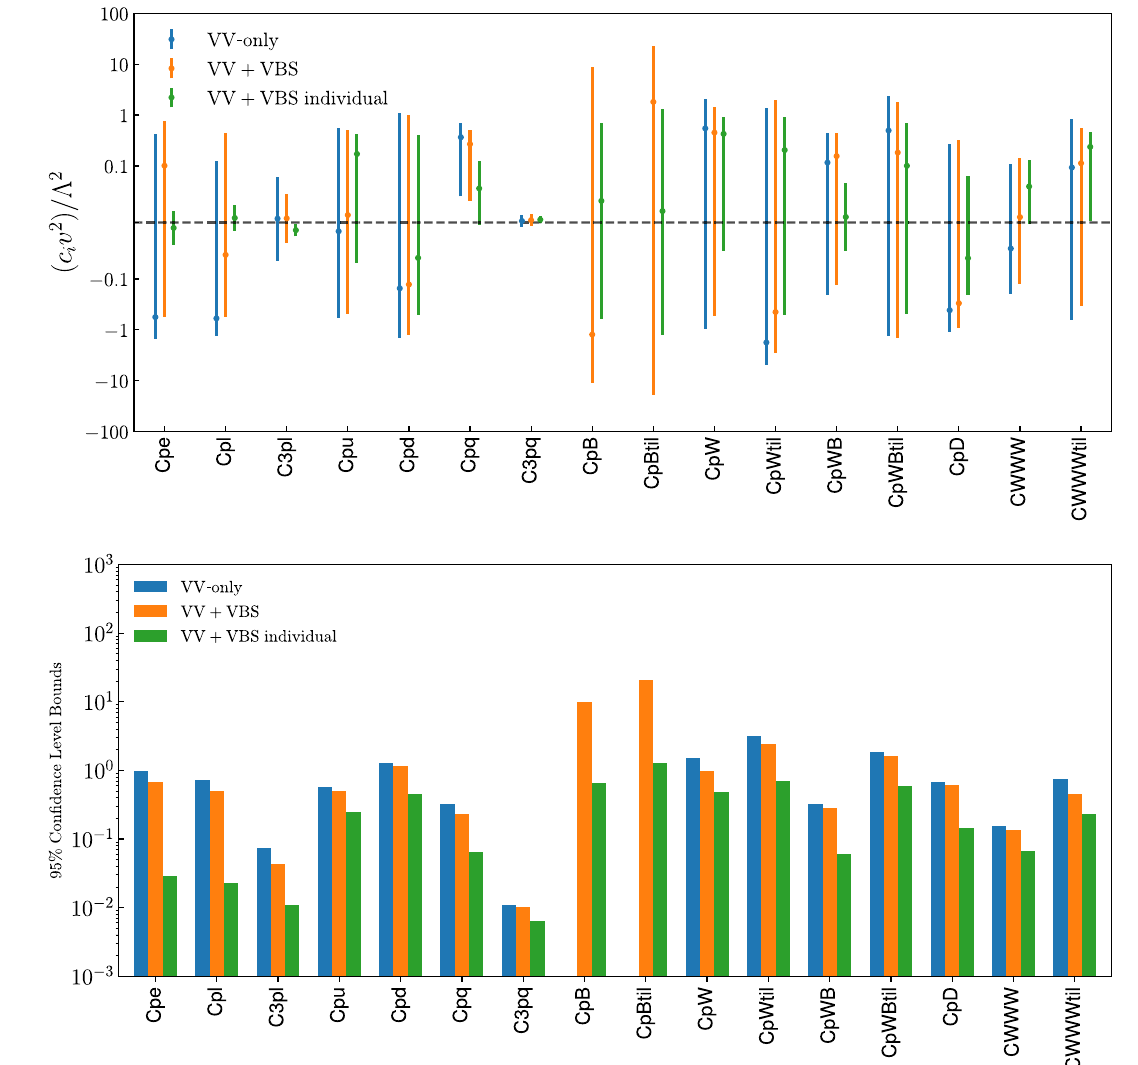
Fig. 20 Graphical representation of the results of Table 9, displaying the absolute value (upper) and the magnitude (bottom panel) of the 95% CL intervals divided by two (that is, the 2 σ error) associated to each of the 16 EFT operators considered here. We compare the marginalised results of a diboson-only fit (blue) with the same fit once VBS data